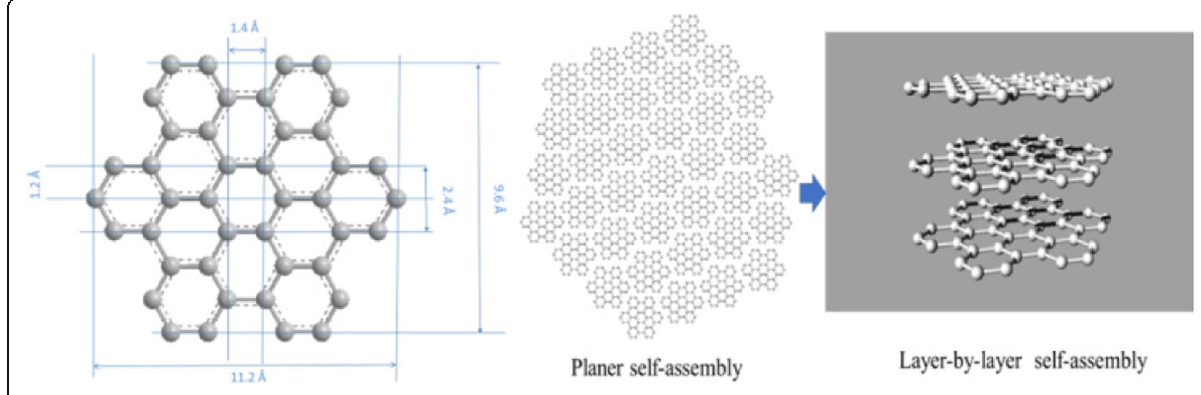
Fig. 1 Hexabenzocoronene structure and self-assembly